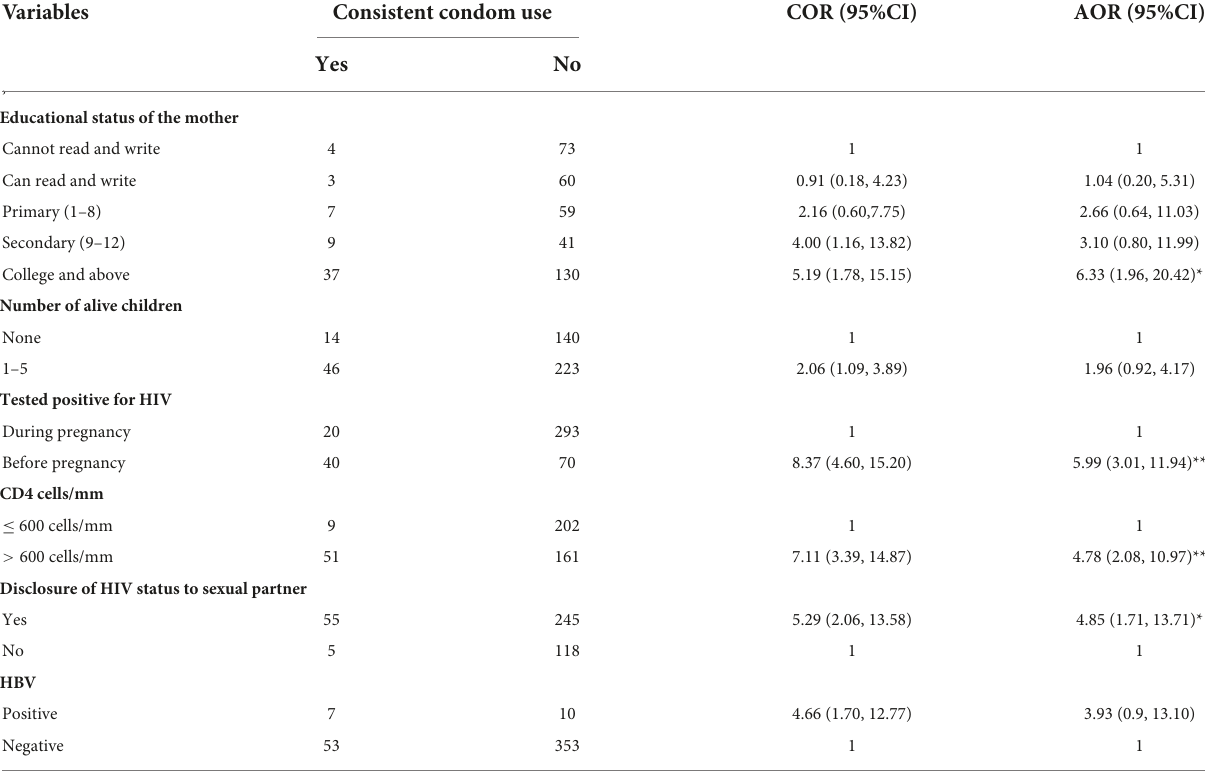
TABLE 3 Bivariable and multivariable logistic regression analysis of factors associated with consistent condom use among HIV-positive pregnant women in the Amhara Region Referral Hospitals, Ethiopia, 2020/2021 ( n = 423). Variables Consistent condom